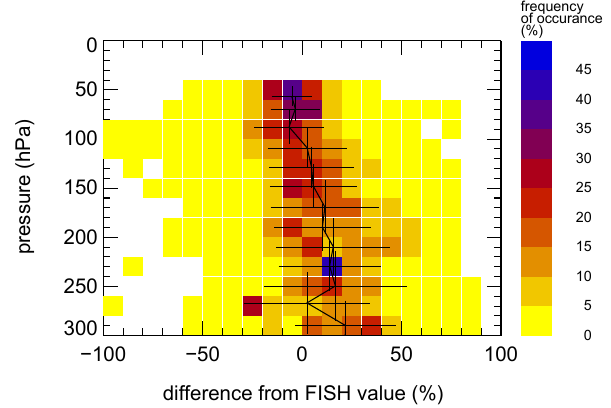
Figure 9. Relative difference between FISH and FLASH water va- por content outside of clouds for all coincident flights between 1999 and 2012 in dependence on pressure (51563 data points = 14.3 flight hours). Clear sky conditions are defined by relative humidi- ties lower than 80%.